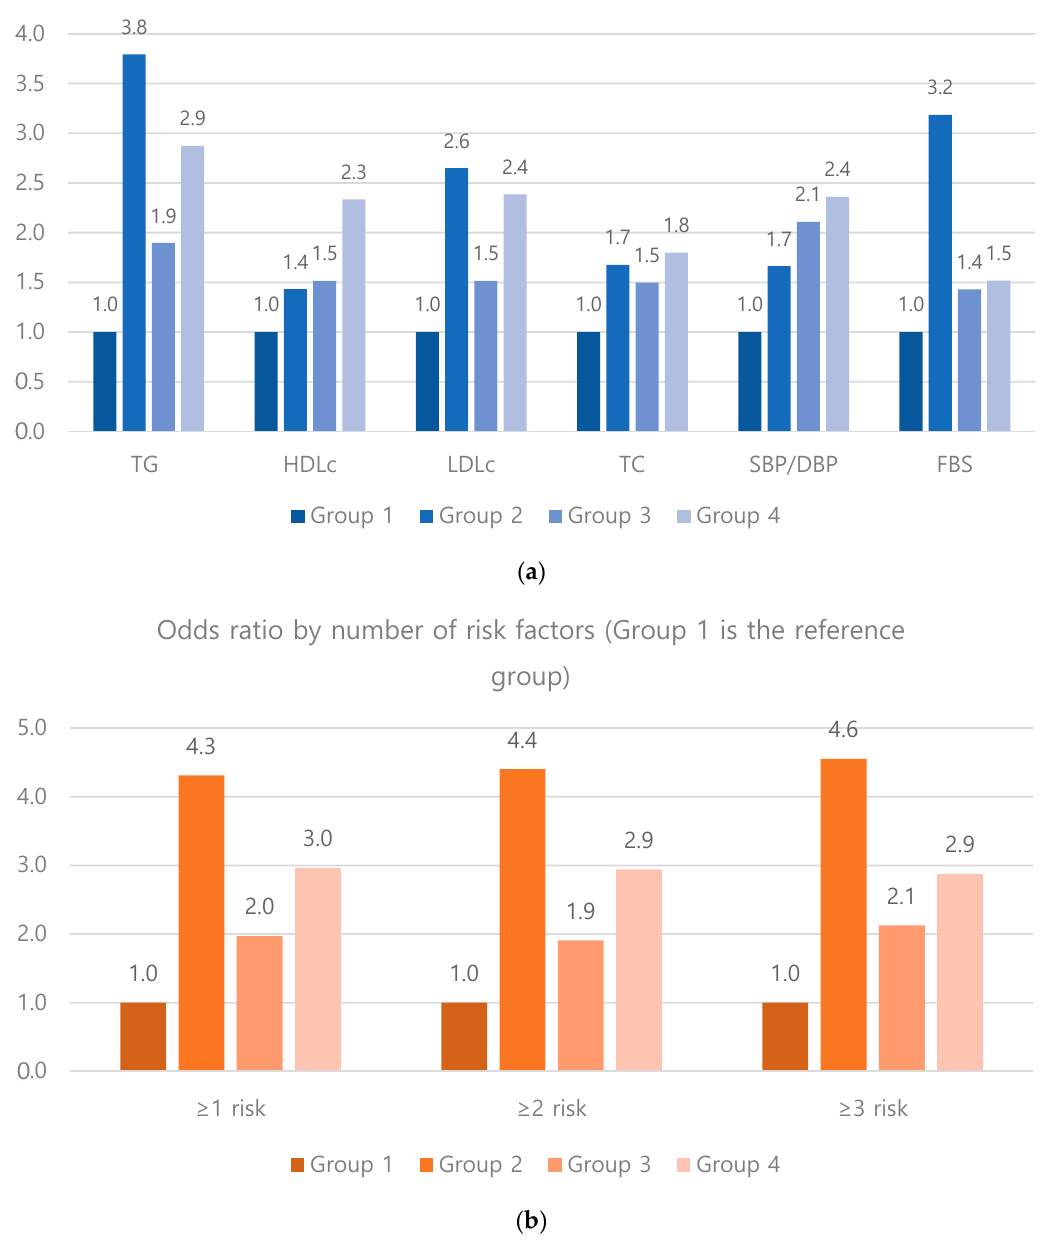
Figure 1. Probability of risk of a problem occurring in metabolic factors. Odds ratios indicates how many times each group has the risks are compared to Group 1. Group; 1: BMI < 25, WC < 90, 2: BMI < 25, WC ≥ 90, 3: BMI ≥ 25, WC < 90, 4: BMI ≥ 25, WC ≥ 90.